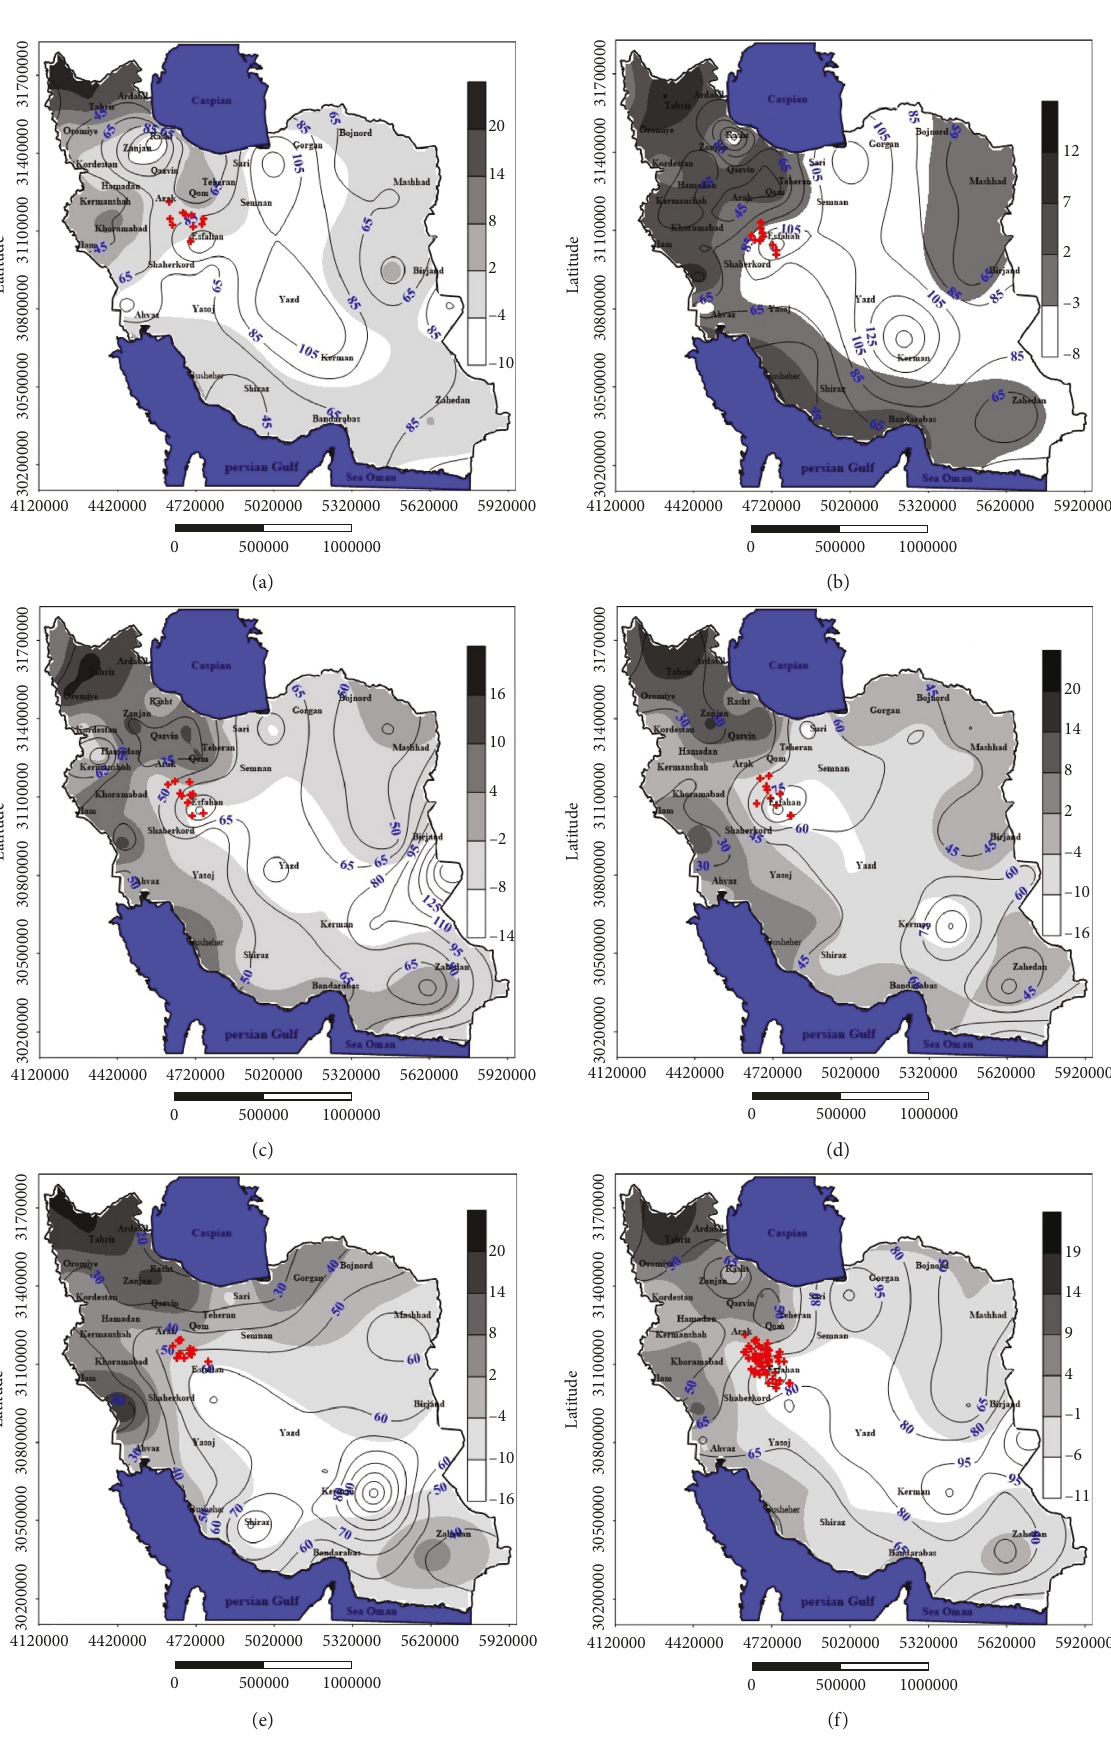
Figure 2: Spatial distribution of mean (contour), center of gravity (+), and anomalies (shaded) of Iran’s thunderstorms in different periods.